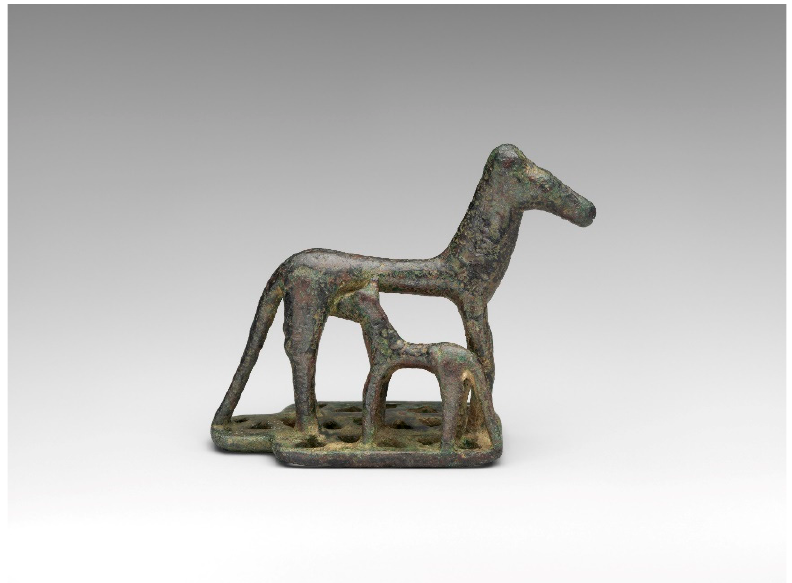
Figure 14. Bronze mare and foal. Late 8th century BCE. Metropolitan Museum of Art. Gift of Mrs. Frederick M. Stafford in memory of Mr. Frederick M. Stafford, 1999. Inv. no. 1999.526.